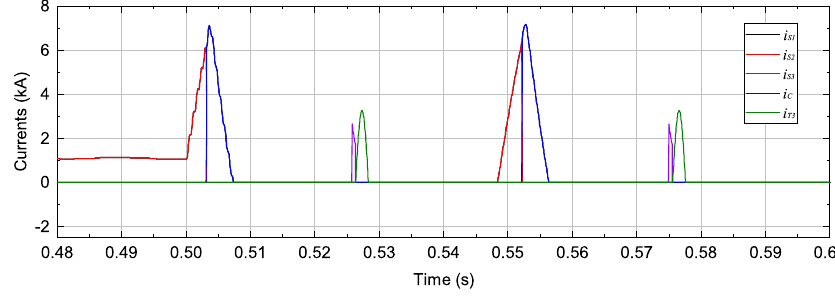
Figure 13. Overall currents on the switches of HCB 1.